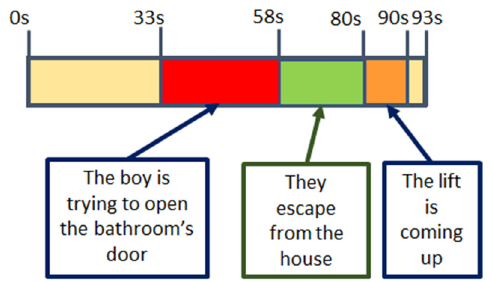
Figure 12. V02 main stressful events. “Refugiado” Diego Lerma 2014. Available at [62]. With regard to V4, all the scenes are stressful but peak instants are when lights go off (seconds 38 and 88) and there are screams or sudden hits/blows (seconds 12, 22, 63, and 105). The worst moment is when two people appear suddenly in front of the viewer, no- faced, with loud music and screams (105); all features show a change of behaviour around this final scare that has been under preparation right from second 63. Figure 13. V04 main stressful events. “Chamber of horrors” Inside 360 VR Prod 2018. Available at [62]. 4.3. Catecholamine Concentration The concentration of adrenaline, dopamine and nor-adrenaline catecholamines, has been measured as detailed in Section 3, with the HPLC technique. In Table 5 the concen- tration values for these catecholamines are detailed per volunteer. A global analysis of these values has been performed to determine the relationship between the emotional re- action and these concentrations. First, the box plots of mean and quartile for every video clip were obtained, Figure 14. Second, to analyse the temporal evolution of these concen- trations, temporal graphs were plotted, in Figures 15 and 16.